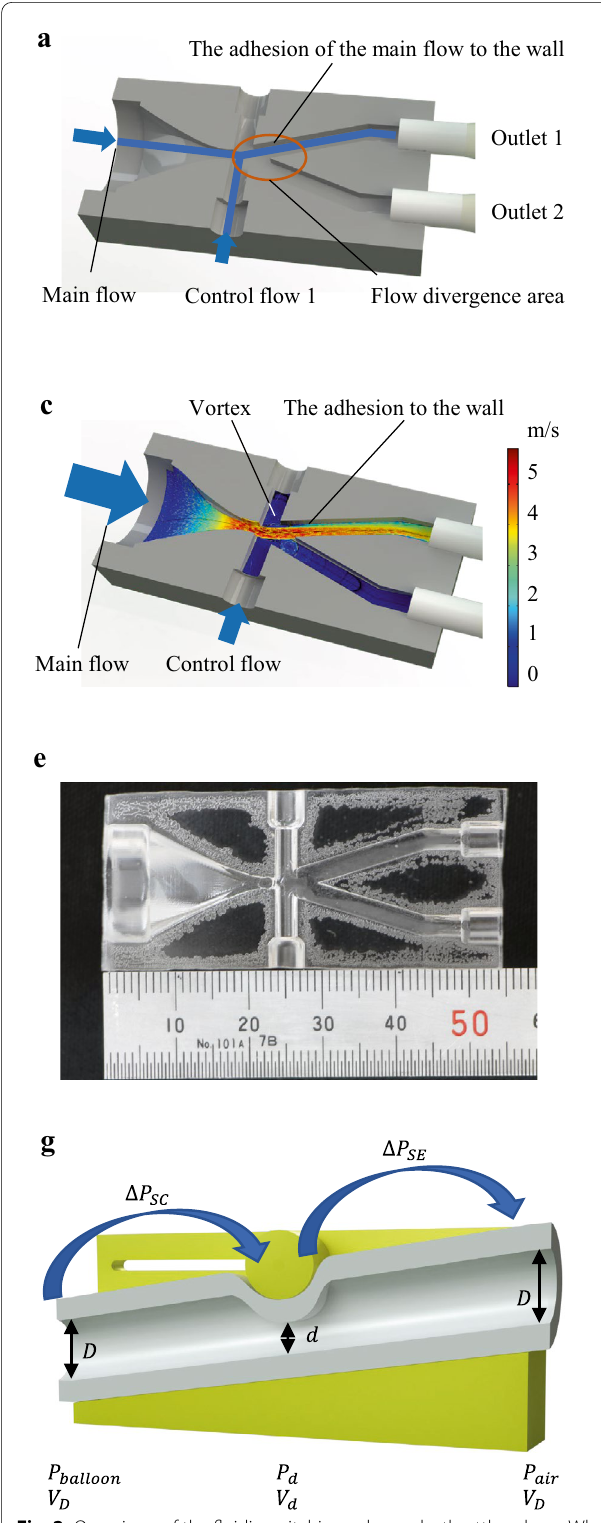
Fig. 2 Overviews of the fluidic switching valve and a throttle valve. a When the control flow 1 is introduced. b When the control flow 2 is introduced. c The Coanda effect observed in the fluidic switching valve. d Crosssection and dimensions of the developed fluidic switching valve. e Actual view of the valve. f An overview of the throttle valve. g Cross-section of the throttle valve. h A model of the throttle